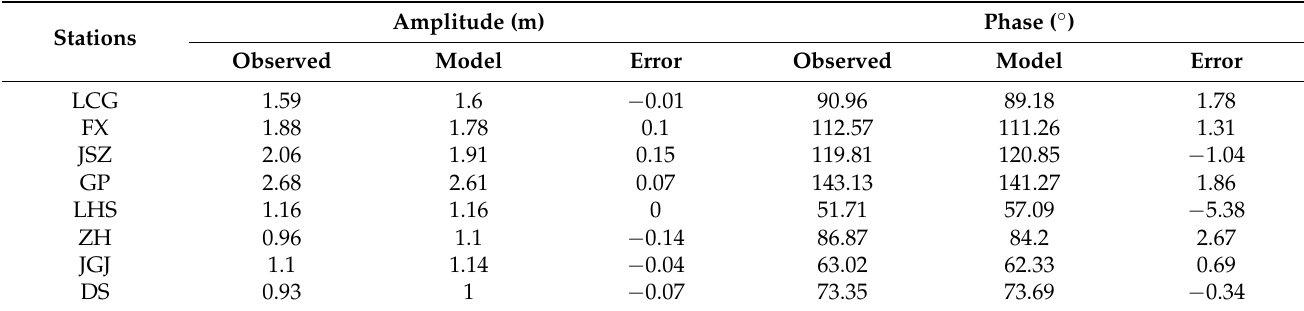
Table 1. Comparison of the mode and observed M 2 tidal constituent at the stations (see Figure 1 for the positions).